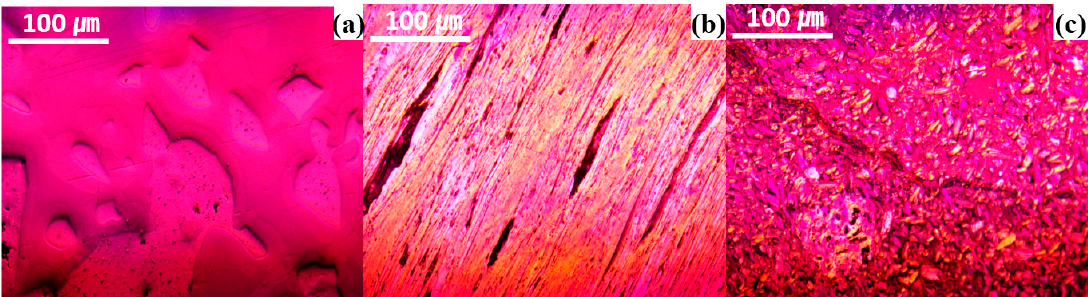
Figure 1. Optical structure of material; ( a ) binder pitch polymer; ( b ) bulk needle coke; ( c ) crushed needle coke.